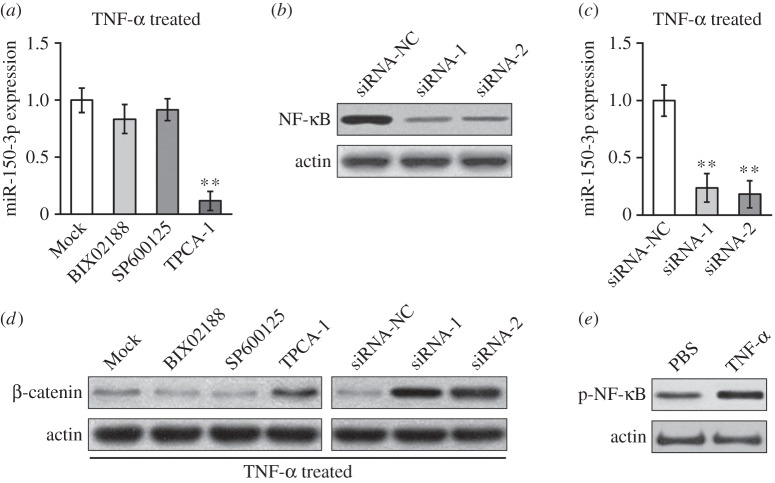
IKK activation was essential for TNF-α induced upregulation of miR-150-3p in hBM-MSCs. (a) Expressions of miR-150-3p in hBM-MSCs treated with p38 MAPK inhibitor BIX02188, JNK inhibitor SP600125 and IKK inhibitor TPCA-1, respectively, in the presence of TNF-α. (b) NF-κB protein and (c) miR-150-3p levels in hBM-MSCs transfected with siRNAs against NF-κB were examined. (d) β-catenin protein levels in hBM-MSCs treated with small inhibitors (left panels) or siRNAs against NF-κB (right panels) in the presence of TNF-α were examined with Western blot. (e) Levels of phosphorylated NF-κB at Ser536 (p-NF-κB) in hBM-MSCs treated with either PBS (as control) or TNF-α. Data presented as mean ± s.d. from at least three independent experiments. **p < 0.01 compared with respective Mock or siRNA-NC control.